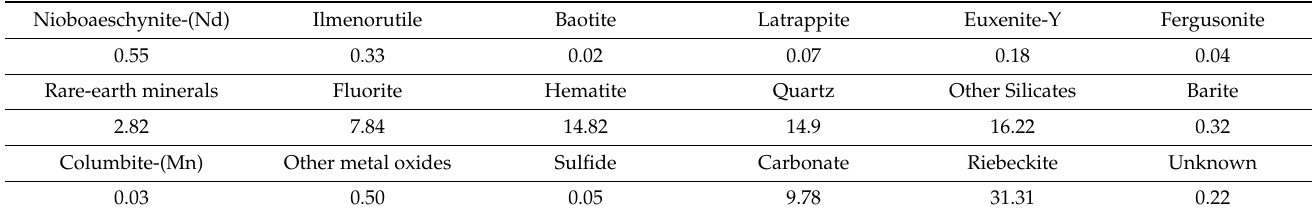
Table 3. Mineral composition of the selected niobium ore (area fraction) %.